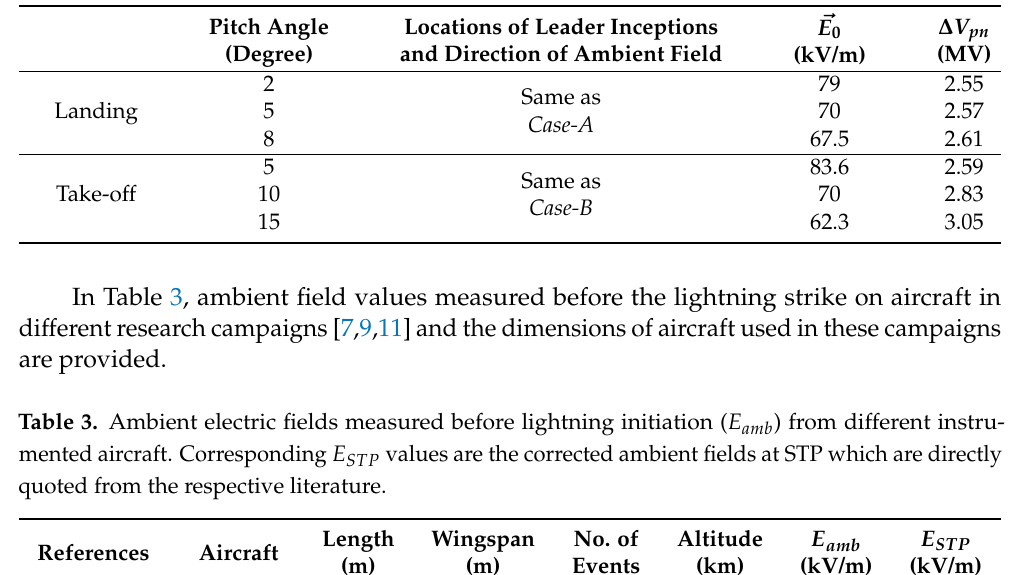
Table 2. Dependency of the minimum ambient field required for the bi-polar discharge inception on the aircraft orientation for different pitch angles. Pitch Angle Locations of Leader Inceptions (Degree) and Direction of Ambient Field